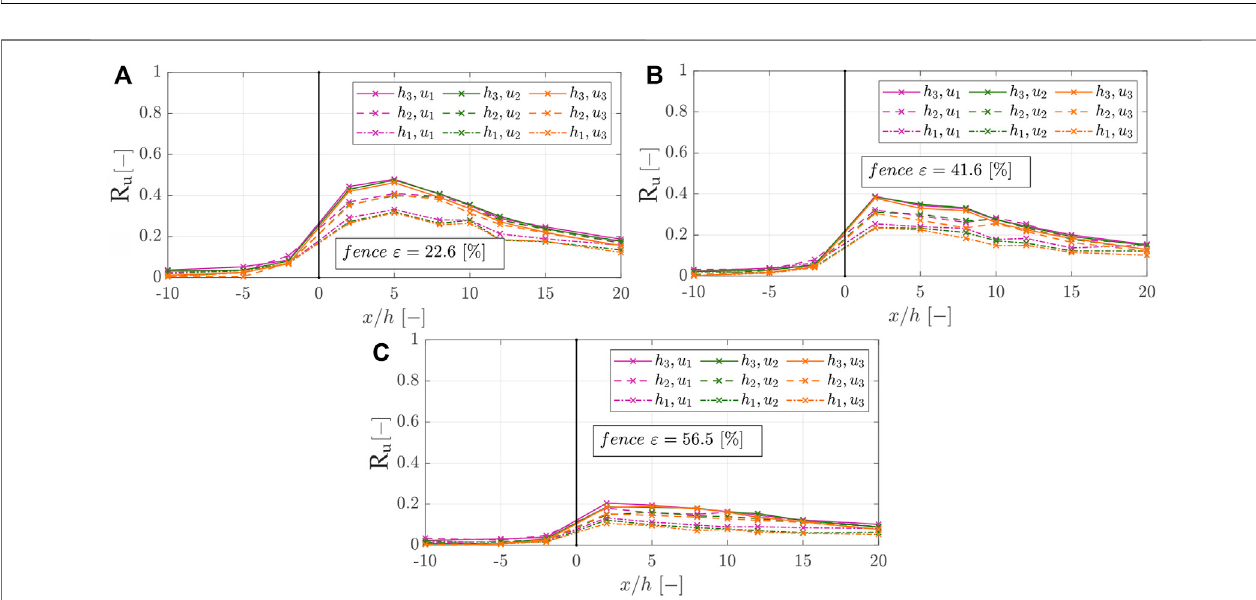
FIGURE 12 | Wind reduction coef fi cients accordingly to Eq. 9 in the x -direction of fences with different characteristics, which are divided into (A) the fence porosities ε 1 = 22.6%, (B) ε 2 = 41.6%, and (C) ε 3 = 56.5%.